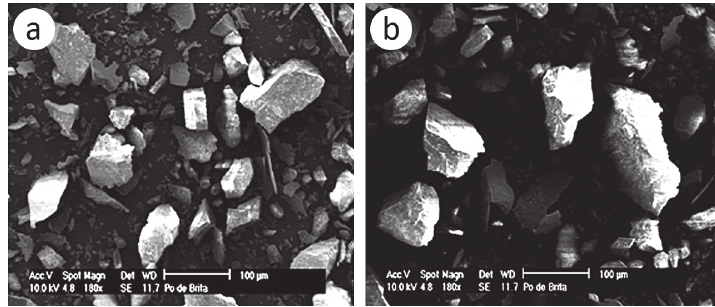
Fig. 4 - SEM micrographs of the granite powder particles: magnification of (a, b) 180 times.